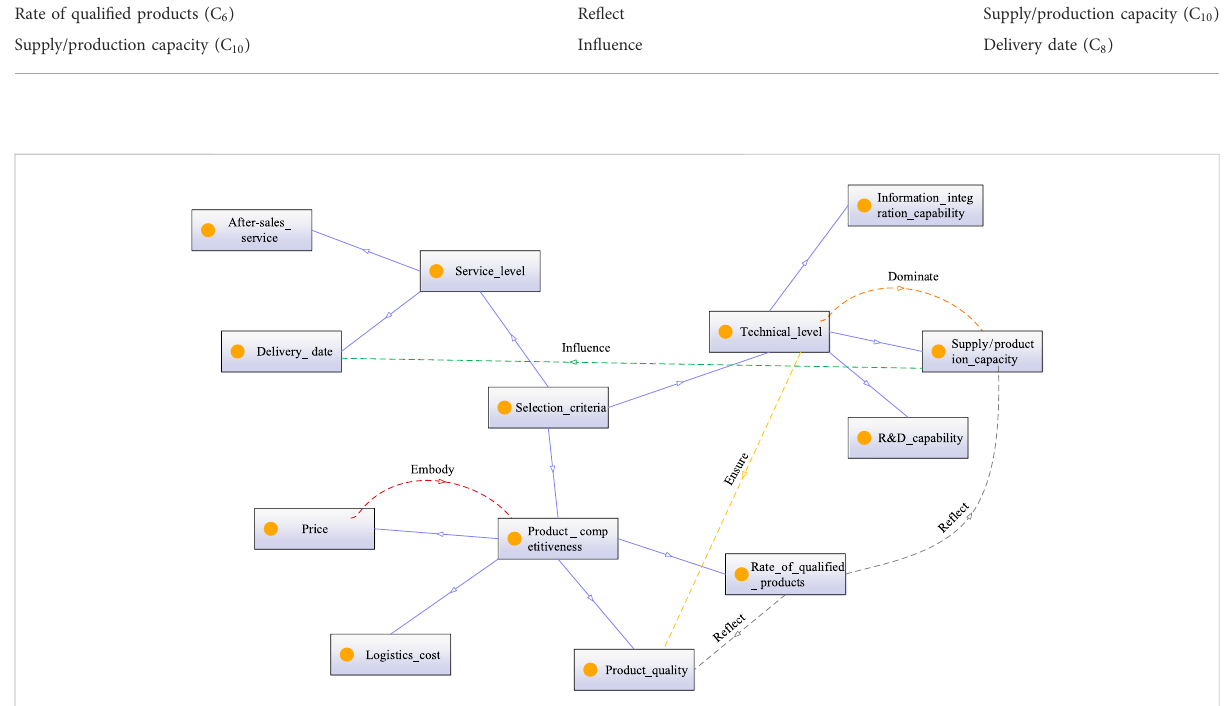
FIGURE 9 Initial domain ontology for NEV component supplier selection